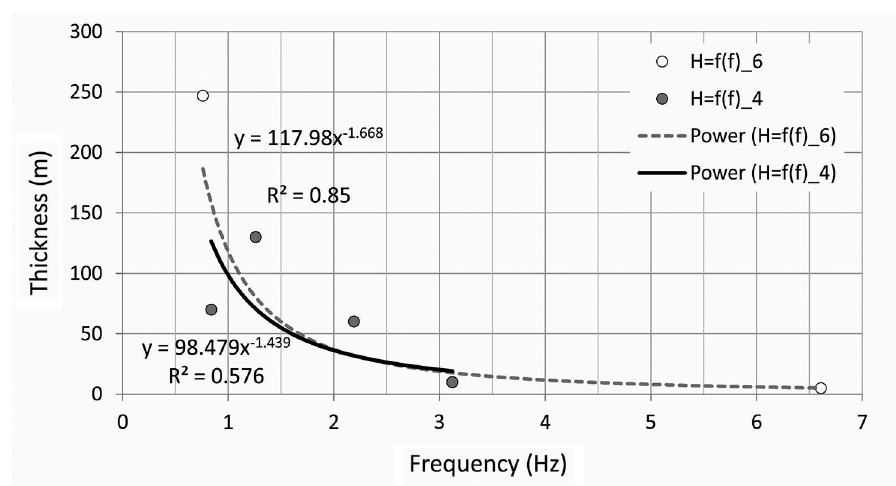
Fig. 4. Interrelation between frequencies of HVSR peaks on the basis of ambient seismic noises and thickness of Quaternary deposits. H = f(f)_6 and H = f(f)_4 – the values for estimating the dependence of the thickness of Quaternary deposits from frequency, respectively for 6 and 4 observational points; Power (H = f(f)_6 and Power (H = f(f)_4 – trend line on power law averaging, respectively for 6 and 4 observational